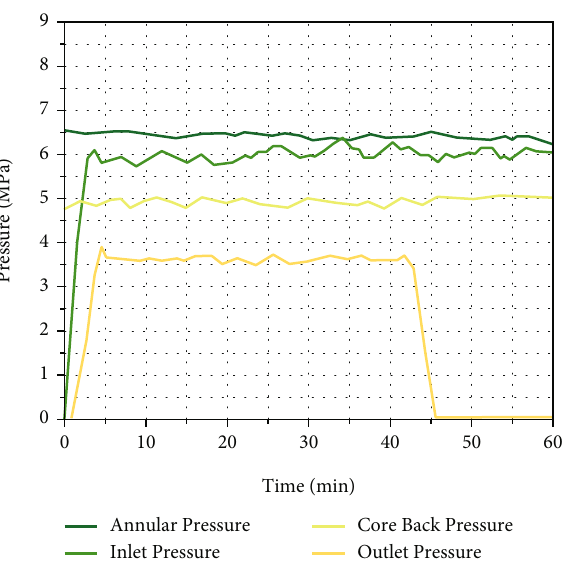
Figure 17: Experiment 8 plugging pressure change.